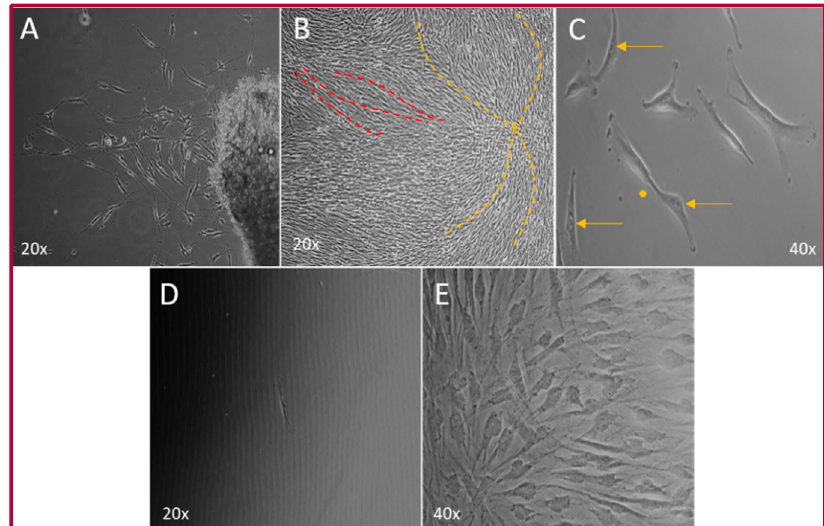
Figure 1. hOMSC culture. ( A ) Explant of oral mucosa, where cells can be observed migrating outward from the tissue fragment. ( B ) Cell culture at 90–100% confluence grouped in small currents (red lines) and in storiform pattern (yellow lines). ( C ) Individual cells, showing central nucleus with prominent nucleolus (yellow arrows). ( D ) Single cell culture at day 1. ( E ) Colony of cells showing a homogeneous morphologic phenotype.